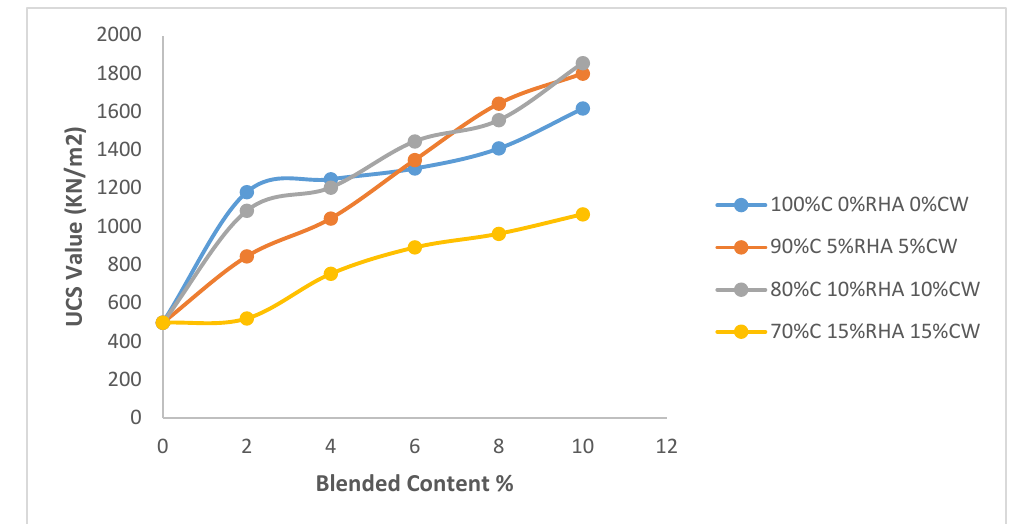
Fig. 12. Relationship between the 28days UCS values of laterite treated with (100%C 0%RHA 0%CW), ( 90%C 5%RHA 5%CW),(80%C 10%RHA 10%CW)& (70%C 15%RHA 15%CW) blend of cement.